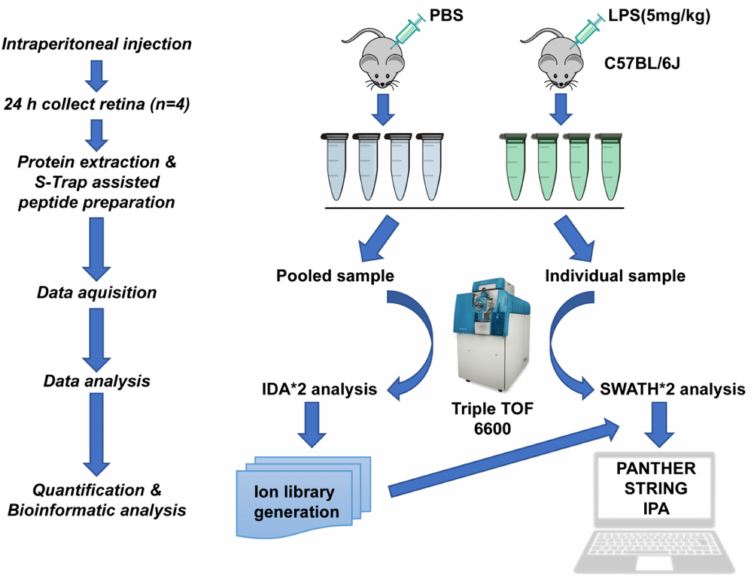
Figure 7. Schematic workflow of quantitative discovery proteomics in the retina from C57BL/6J mice treated with an intraperitoneal injection of LPS or PBS solution (n = 4 for each group) by SWATH-MS. The peptide was prepared based on S-Trap filter and trypsin digestion. The 2 µ g of peptides from each retina sample was analyzed by a Triple-TOF 6600 MS. The acquired data were further analyzed with bioinformatic online tools including ProteinPilot, PANTHER, STRING, and